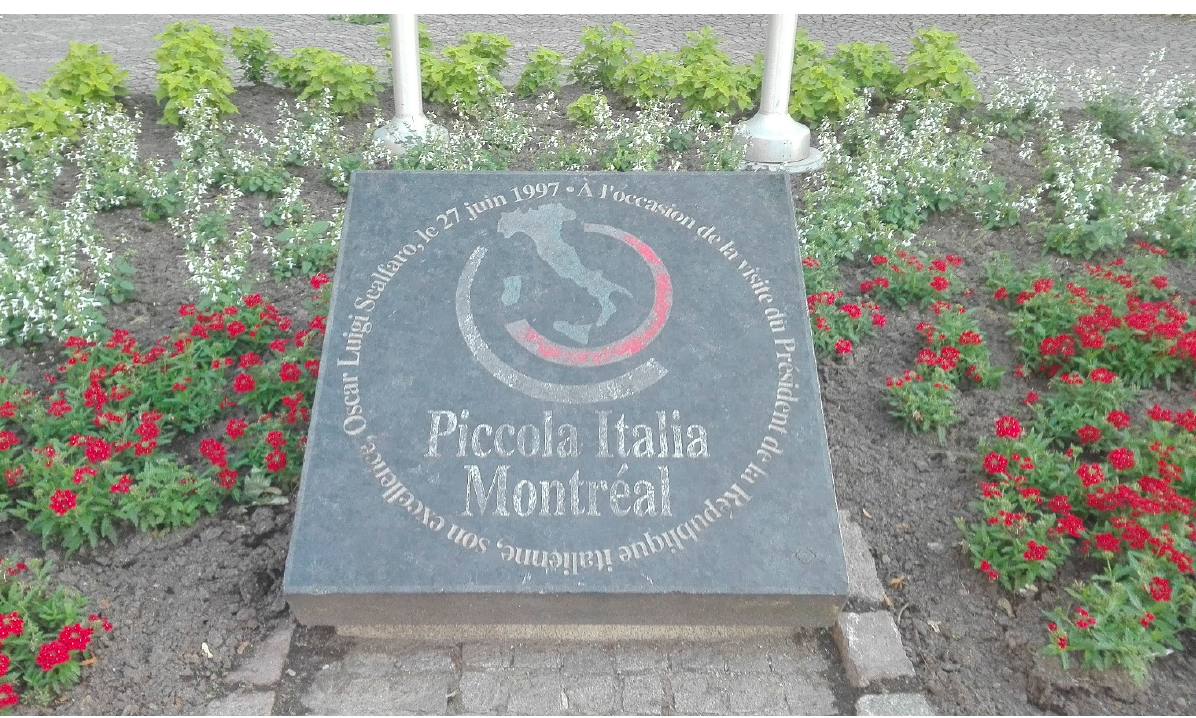
Figure 2. Parc de la Petite-Italie , Saint-Laurent/Saint-Zotique. The park is located next to Little Italy’s entrance arches.